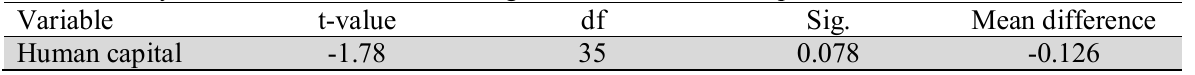
The summary of t-student test for measuring the effect of human capital